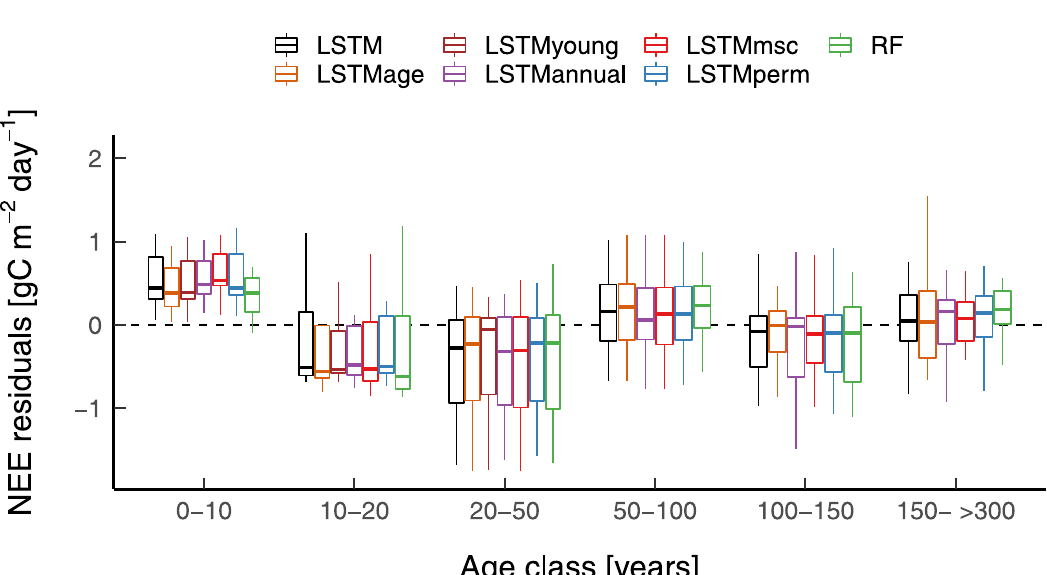
Fig 8. Model residuals per age class for LSTM , LSTM perm , LSTM msc , LSTM annual , and RF models based on site-average NEE. LSTM = LSTM model using the full depth of the Landsat time series and climate data; LSTM perm = LSTM model but the temporal patterns of both the predictive and the target variables were randomly permuted while instantaneous relationships between predictive and target variables were kept; LSTM msc = LSTM model but the Landsat time series for each band were replaced by their mean seasonal cycle, while using the actual values of air temperature (T ), precipitation (P), global radiation (Rg), and vapor air pressure deficit (VPD); LSTM annual = LSTM model but the Landsat time series for each band were replaced by their annual mean, , P, Rg, and VPD, RF = Random Forest model using the actual values of the Landsat time series while using the actual values of T air and climate data.; LSTM age = LSTM + forest age as a predictive variable; LSTM young = LSTM only trained with forests younger than 40